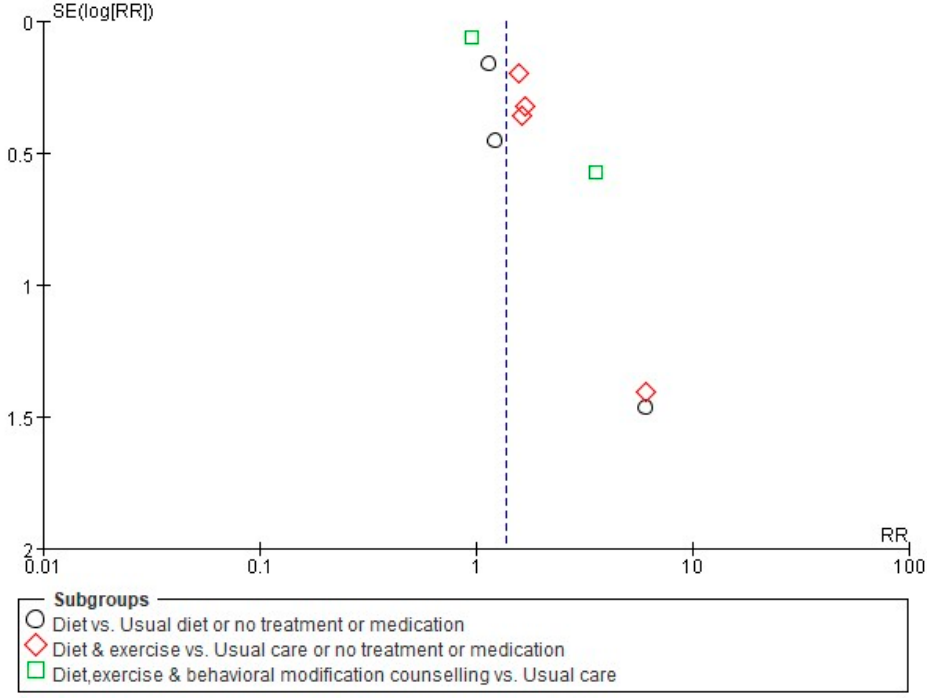
Figure 8. Funnel plots of the effects of nonpharmacological intervention on pregnancy rate.